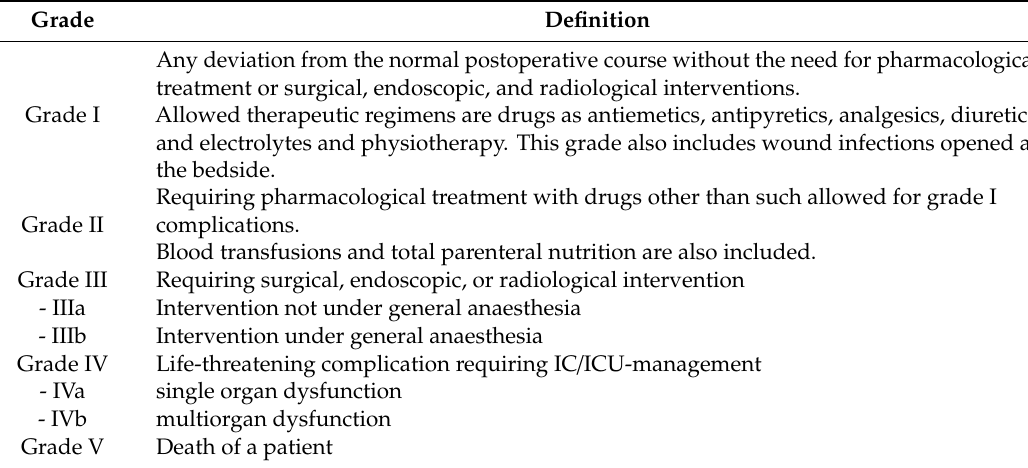
Table 1. The Clavien-Dindo Classification.